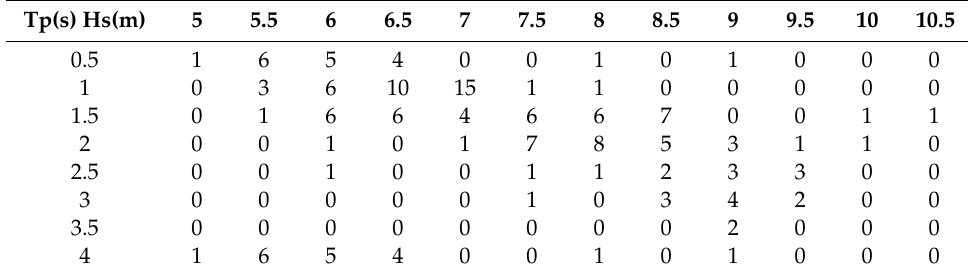
Table 5. Example of the number of occurrences for each sea state (monthly average) for a point in the Atlantic region of Spain.